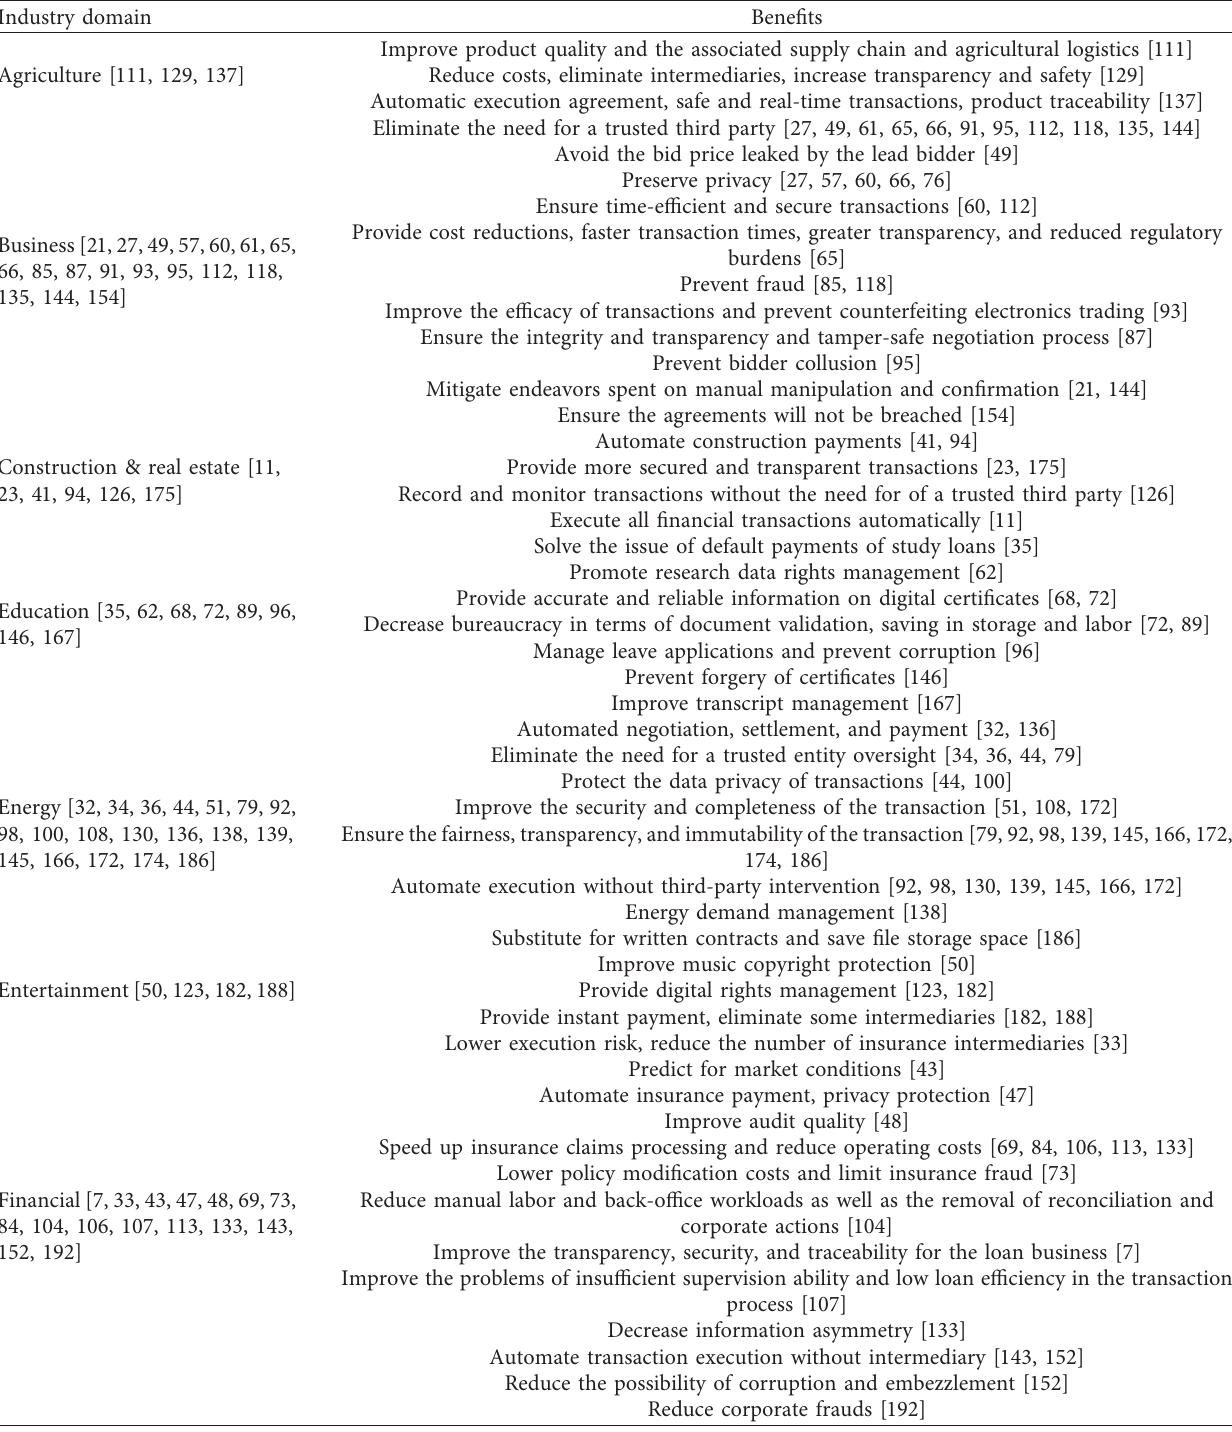
Table 5: Benefits of utilizing smart contracts in various